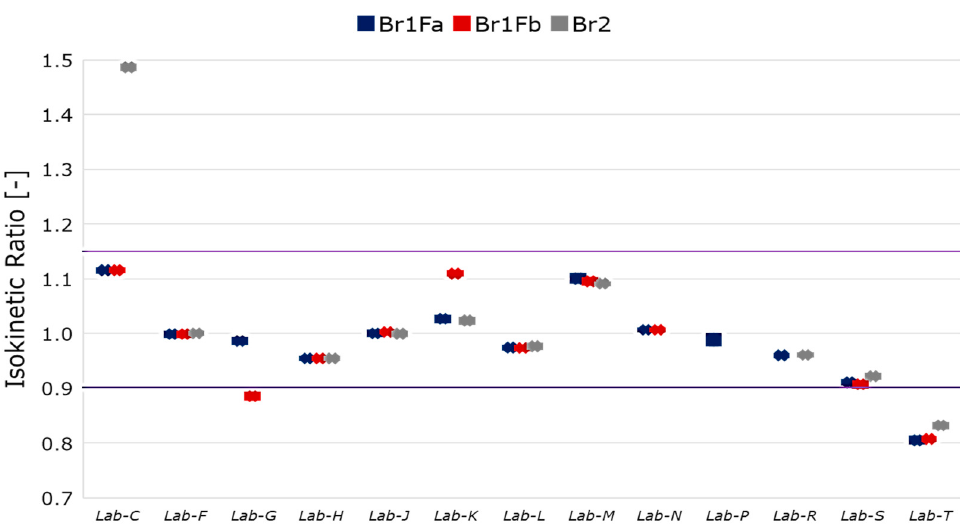
Figure 6. Isokinetic ratio for PM10 sampling with Br1Fa, Br1Fb, and Br2. Data for all three repetitions of the PM10 measurement are plotted. Lab D’s isokinetic ratio was not able to be calculated due to errors in the submitted files.